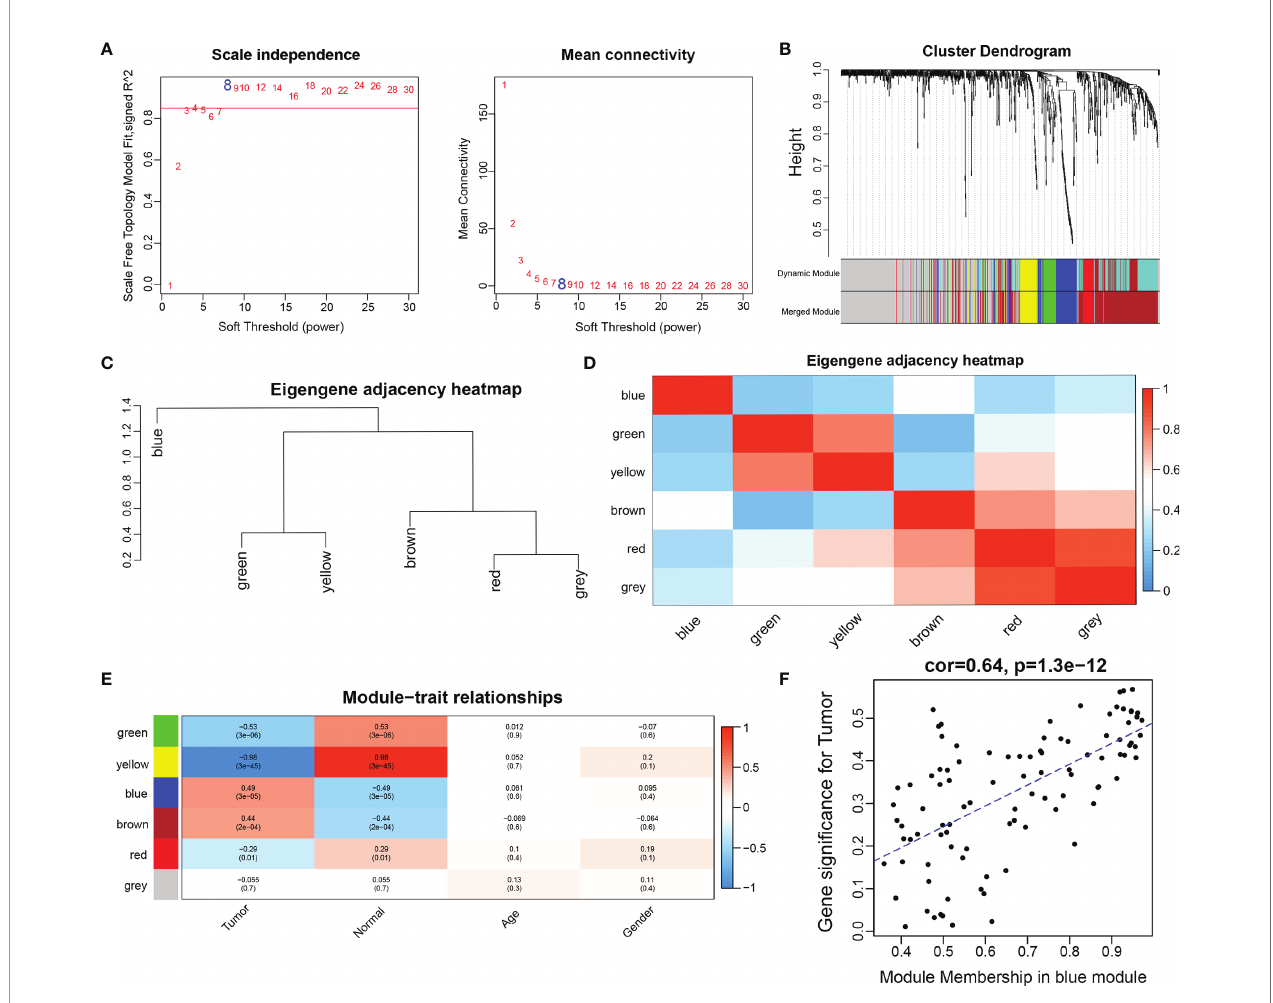
FIGURE 2 | Construction of weighted gene co-expression network. (A) network topographies with different soft threshold powers; (B) gene tree diagram obtained by clustering based on the same topological overlap with the corresponding color rows indicating the module colors; (C) clustering analysis of each module; (D) correlation analysis of each module; (E) correlation between each module and clinical information; (D) scatter plot of correlation between gene module af fi liation and gene signi fi cance in blue modules). (F) scatter plot of correlation between gene module af fi liation and gene signi fi cance in blue